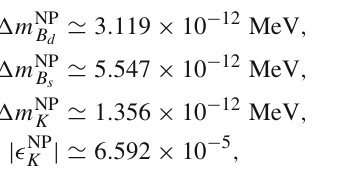
dependent functions. X ( x i ) and Y ( x i ) are obtained by com- bining box functions with Z penguin functions, whereas Z ( x i ) is obtained by combining photon and Z penguin func- tions. S ( x i , x j ) is a box diagram function that is relevant in meson mixings and E ( x i ) is associated with gluon